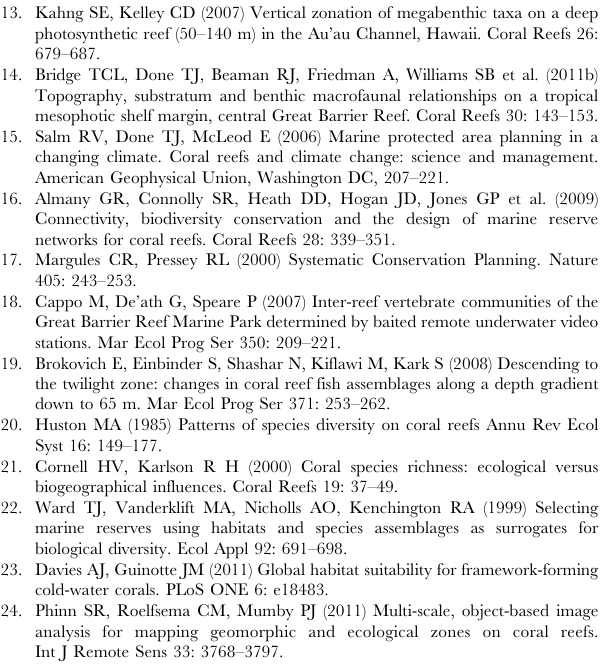
Table S2 AUC Values and jackknife measure of variable importance for GEO, ENV, and GEO-ENV models for both phototrophs and